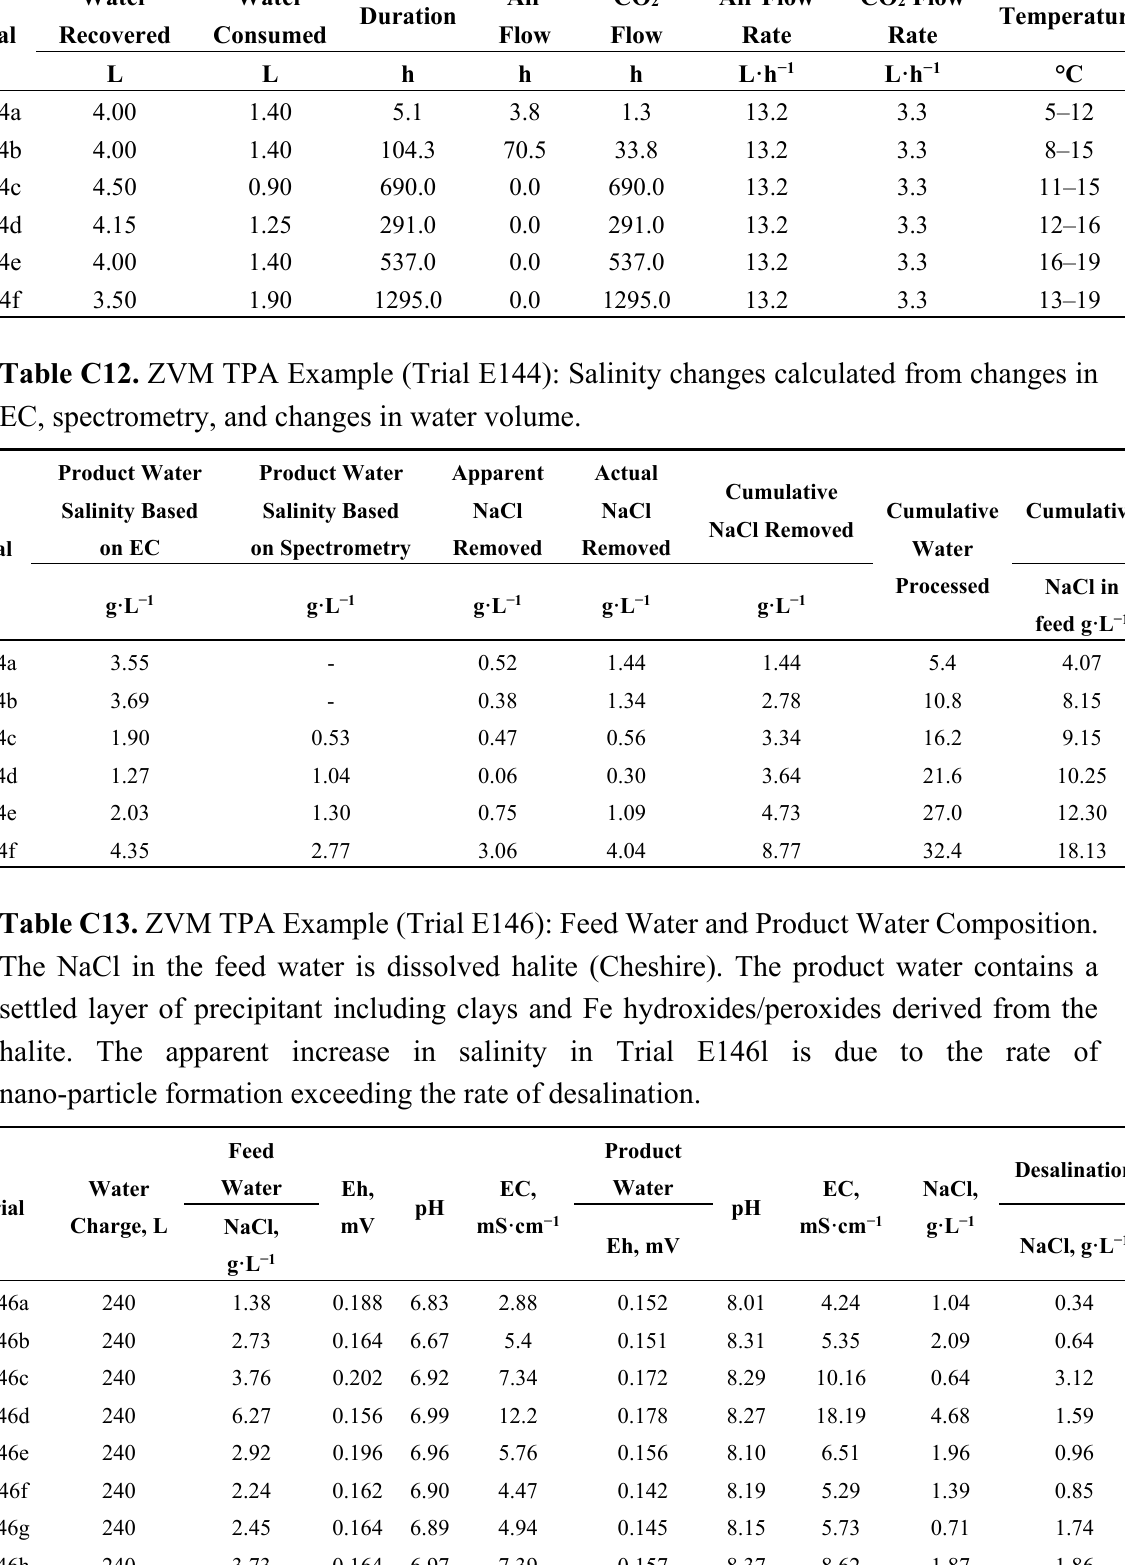
Table C11. ZVM TPA Example (Trial E144): Product Water Volume Recovered, Trial Duration, Temperature, Gas Flows.